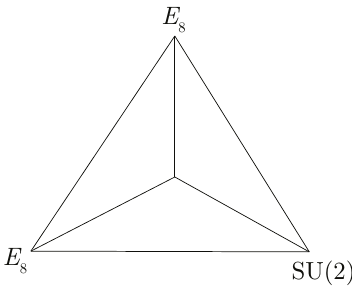
Figure 3 . The ( E 8 , E 8 , SU(2)) collision and a single blow up at the intersection point.